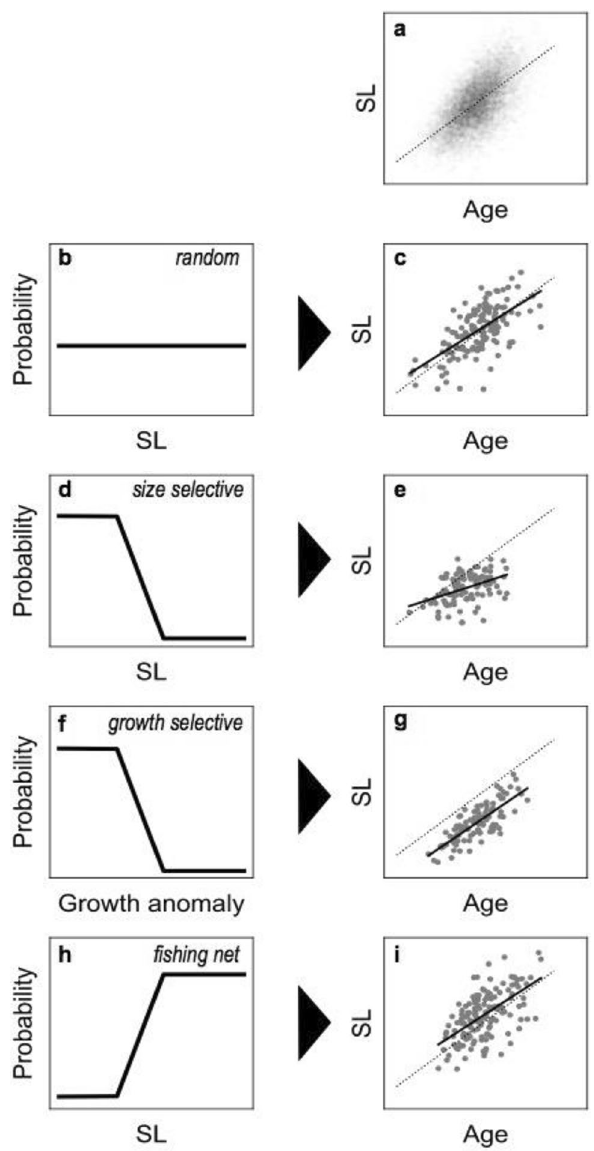
Figure 2. Conceptual models of the effect of predation and net sampling on age–standard length (SL) relationships of consumed or collected specimens. ( a ) Age-SL relationship of the original population consisted of 10,000 individuals with the mean relationship indicated as a dotted line. ( b – g ) Schematics of predation probability of random predation ( b ), size-selective predation ( d ), and growth-selective predation ( f ), and the resulting age-SL relationships of consumed juveniles for each predation model with linear regression (solid line) ( c , e , g ). ( h , i ) Schematic of the collection probability of the fishing net ( h ) and its resulting age-SL relationship of collected juveniles ( i